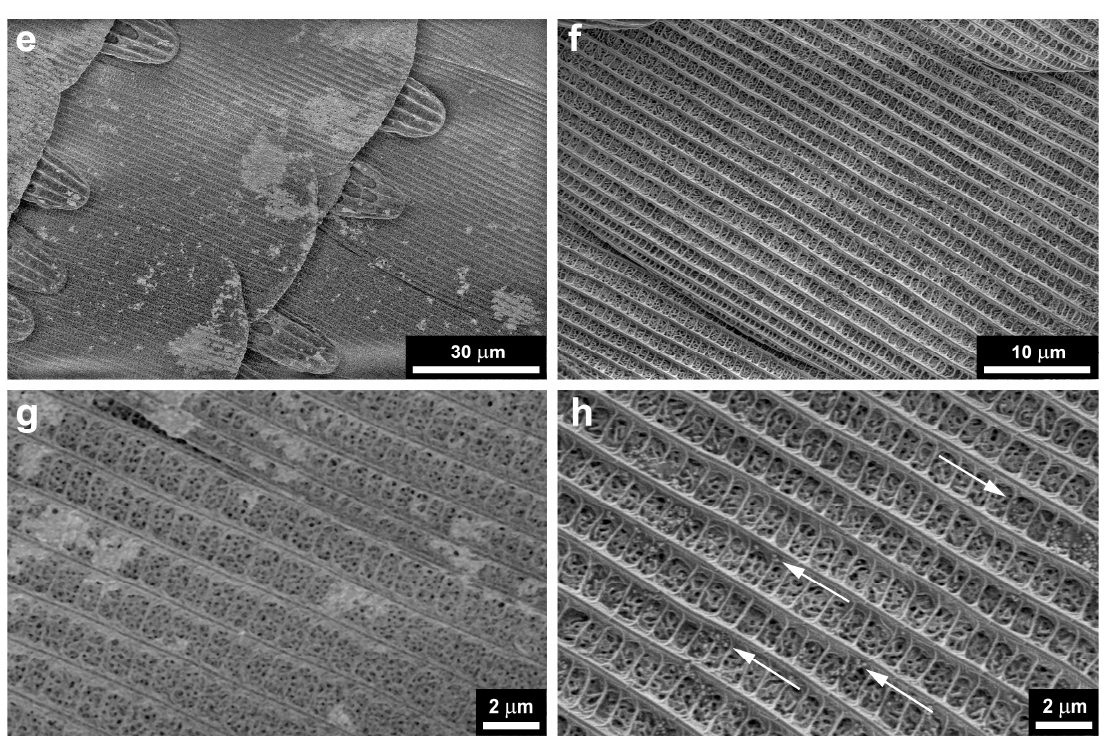
Figure 8. Optical and SEM micrographs of type-1 and type-2 samples after the application of 120 µL of Cu 2 O sol. ( a ) Type-1 sample, optical microscope image recorded with crossed polarizers; ( b ) type-1 sample image recorded on a focus stacking optical microscope using partially crossed polarizers; ( c ) type-2 sample, optical microscope image recorded with crossed polarizers; ( d ) type-2 sample image recorded on a focus stacking optical microscope using partially crossed polarizers; ( e ) SEM micrograph of a type-1 sample; ( f ) SEM micrograph of a sample type-2; ( g ) detail of image in ( e ), note the clustering between the ridges; ( h ) detail of the image in ( f ), note the individual nanoparticles between the ridges marked by arrows.